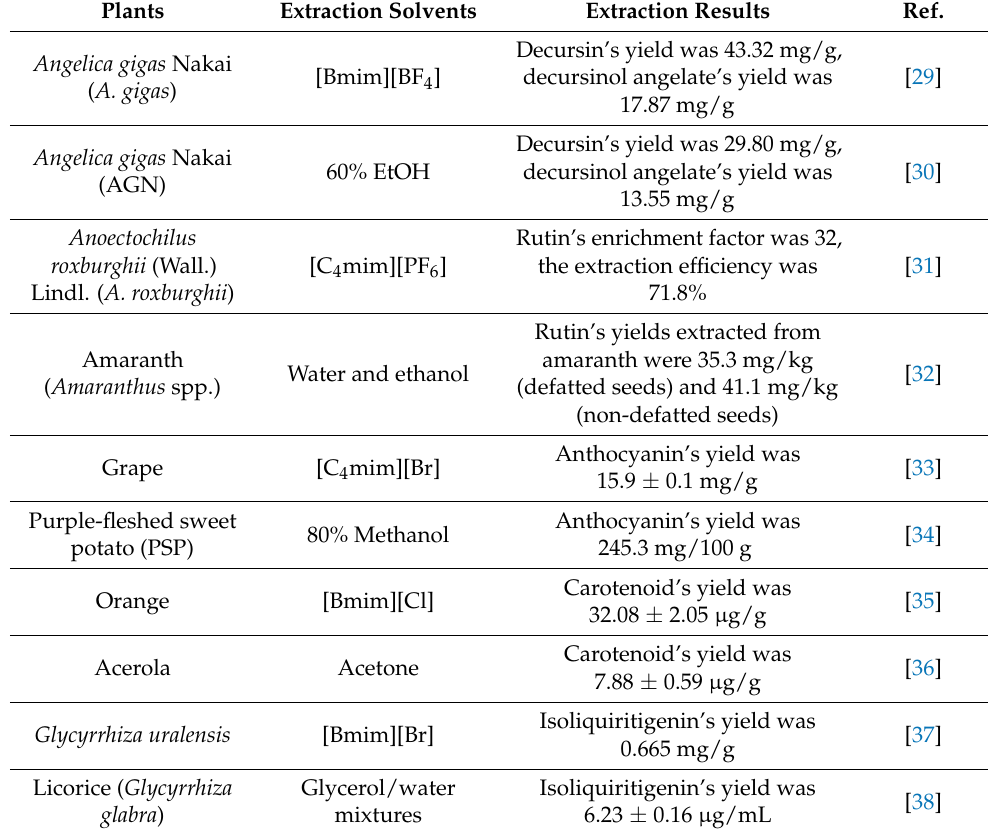
Table 1. Comparison between traditional solvents and imidazolium ionic liquids. Plants Extraction Solvents Extraction Results